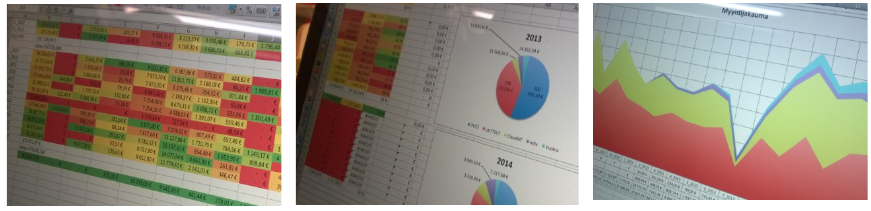
Fig. 3. Examples of financial data visualisations created by an